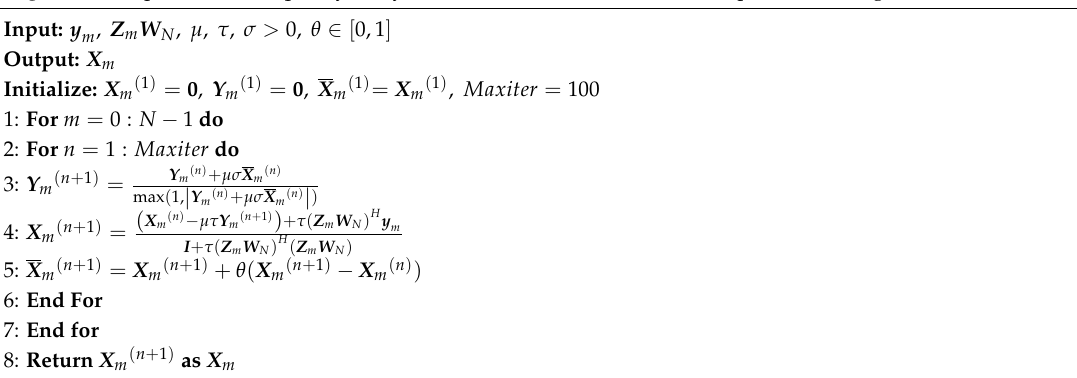
Algorithm 1. Sparse time–frequency analysis method based on the first-order primal-dual algorithm